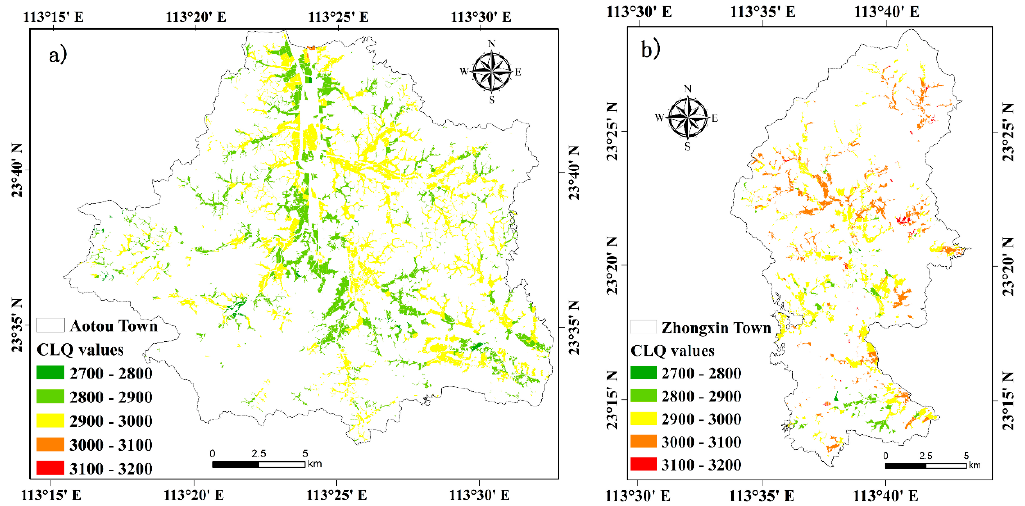
Figure 6. Spatial distributions of the predicted CLQ in 2013 using the GA-BPNN model for the study area: ( a ) Aotou Town and ( b ) Zhongxin Town.